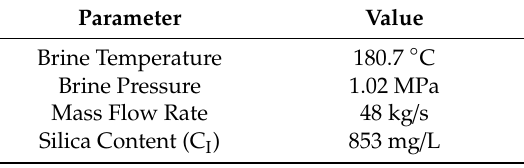
Table 1. Waste Brine Characteristics from the Wayang Windu Geothermal Power